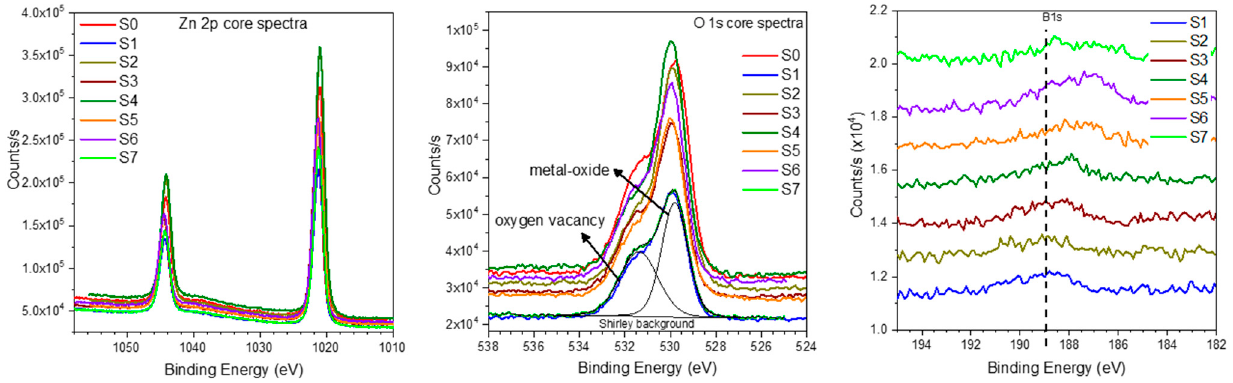
Figure 4. High-resolution XPS spectra of pure and B-doped ZnO films.